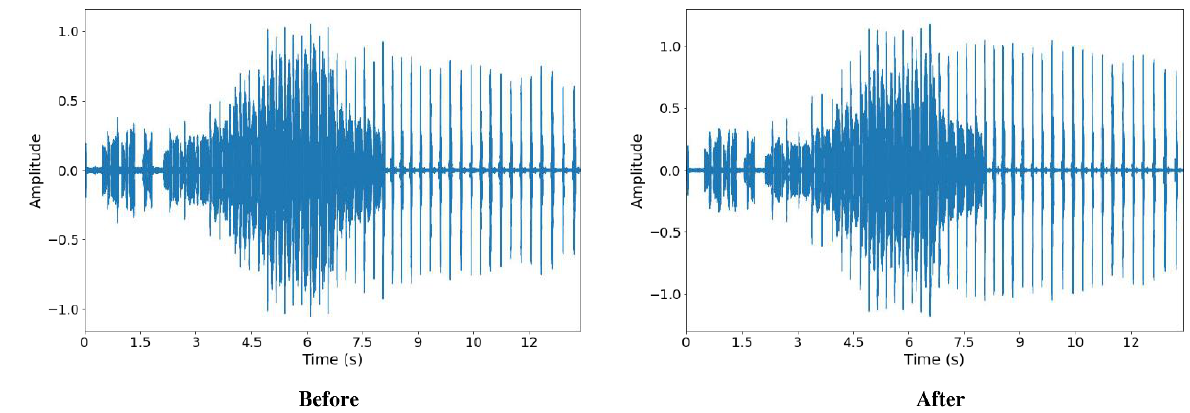
Figure 5. Time domain of signals before and after pre-processing.